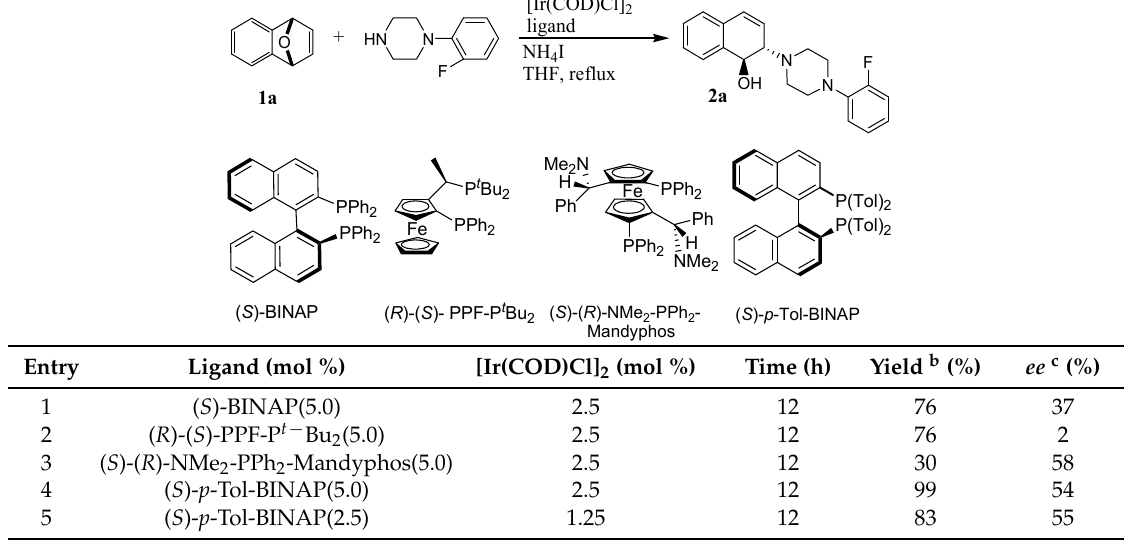
Table 1. Effects of chiral bisphosphine ligands and catalyst loading a